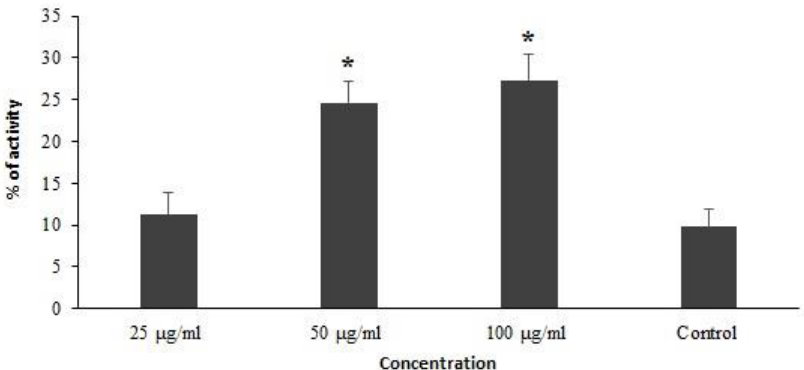
Figure 4. The Caspase-3-like activity of promastigotes of treated with Z. spina-christi methanolic extract using the colorimetric protease methods. The results demonstrate Z. spina-christi methanolic extract elevates the apoptosis activity in dose dependent response. * p < 0.05 shows the difference was statistically significant in comparison with control.